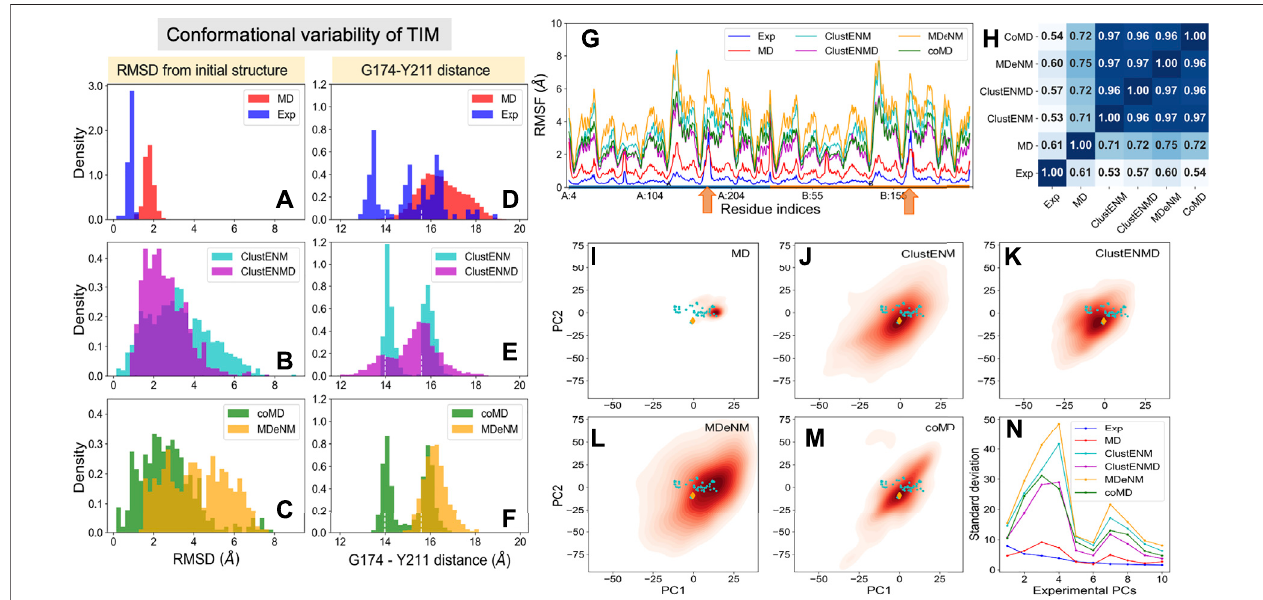
FIGURE 4 | Comparison of the ensembles of conformers experimentally observed and computationally generated for TIM. The panels are in the same format as Figure 2 . (A – C) RMSD histograms with respect to the starting apo structure (PDB id: 1tcd). (D – F) Distances between α -carbons of G174 and Y211 that monitors the opening-closing of the catalytic loop. Dashed lines indicate the loop distances in the different subunits of starting dimeric structure. (G) RMSFs with respect to the initial structureforeachensemble. Orangearrows indicatethecatalyticlooppositionineachsubunit. (H) Pearsoncorrelationcoef fi cientsbetweenpairsofRMSFpro fi les. (I – M) Population distributions of computed ensembles (labeled in each panel) projected onto subspace spanned by e PC1 and e PC2. (N ) Standard deviations of the conformers projected along